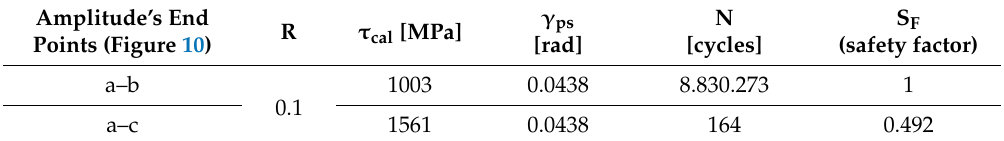
Table 5. Calculated shear stress, shear presetting strains and predicted number of cycles for